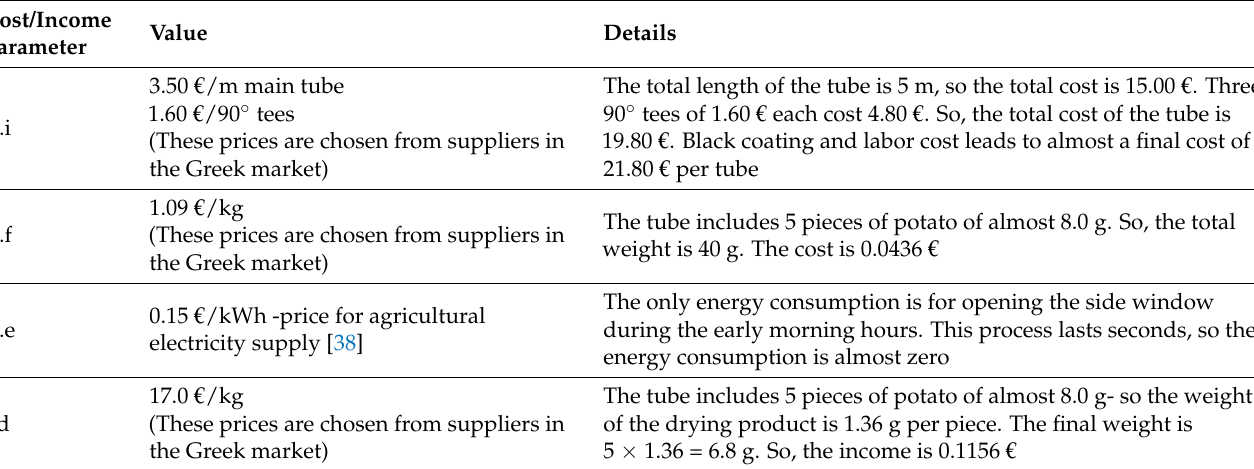
Table 8. Caption. Parameters for the P.B period of potato drying for the prototype examined case